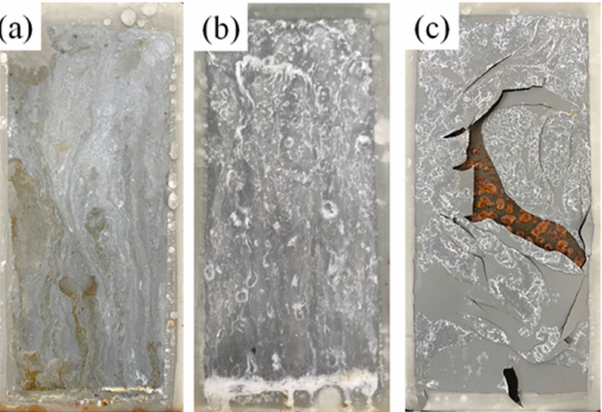
Figure 13. The optical images of WB zinc-based coatings ( a ) 36H-400 ◦ C and ( b ) 36H-500 ◦ C after corrosion test for 1000 h. ( c ) The coating 36H-600 ◦ C was severely attacked after only a 48 h salt spray